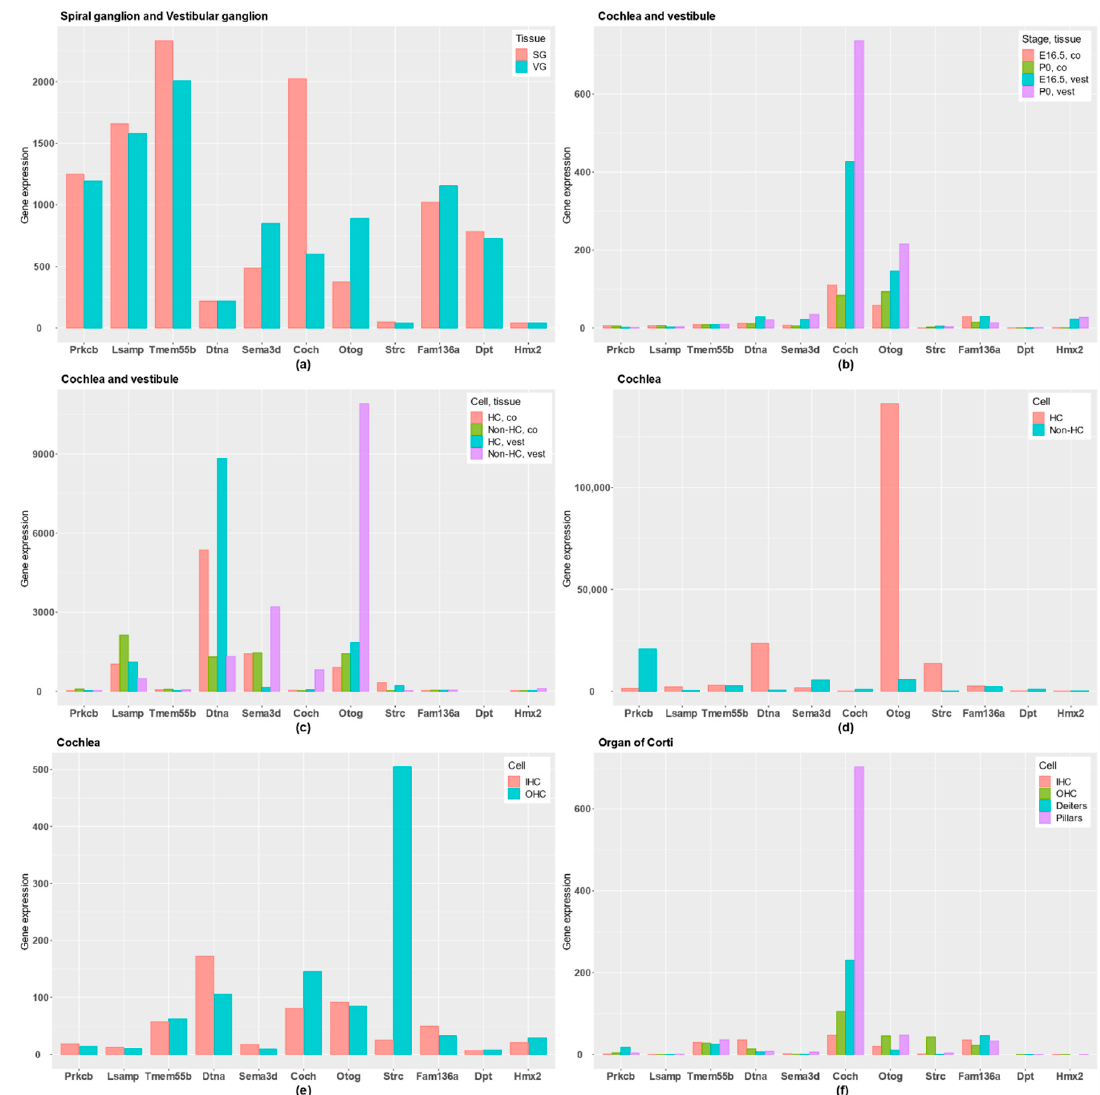
Figure 3. Gene expression profile in candidate genes for FMD in different tissues: ( a ) RNA expression data across inner ear developmental stages in mice comparing SG and VG; ( b ) RNA-Seq data comparing embryonic day 16.5 (E16.5) and postnatal day (P0) between cochlea (co) and vestibule (vest); ( c ) RNA-Seq data at postnatal day (P0) in mice comparing hair cells (HCs) with epithelial non-HCs in both cochlea (co) and vestibule (vest); ( d ) RNA-Seq data from postnatal day (P0) in mice comparing HCs with the rest of cochlear duct in cochlea; ( e ) RNA expression data from adult mice cochlea comparing inner HCs (IHCs) and outer HCs (OHCs); ( f ) RNA-Seq data from adult mice in the organ of Corti, comparing IHCs, OHCs, Deiters’ cells and pillar cells.